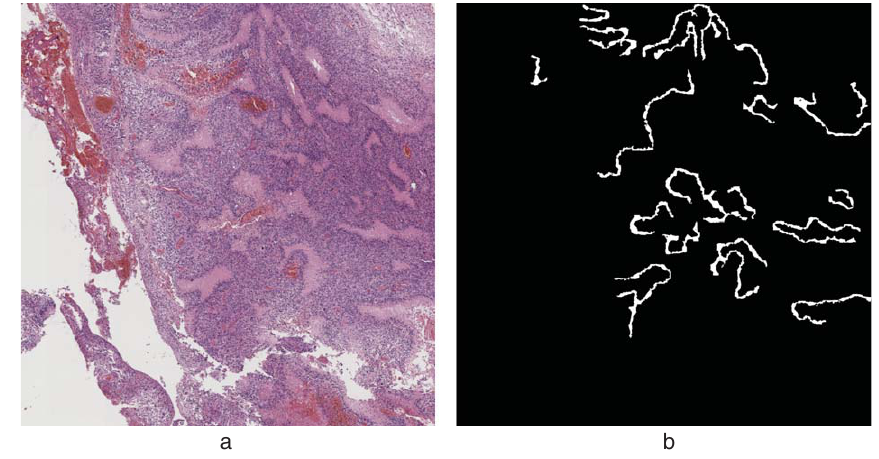
Fig. 4. Filtering pseudopalisading shapes: (a) original virtual slide, (b) detected pseudopalisading